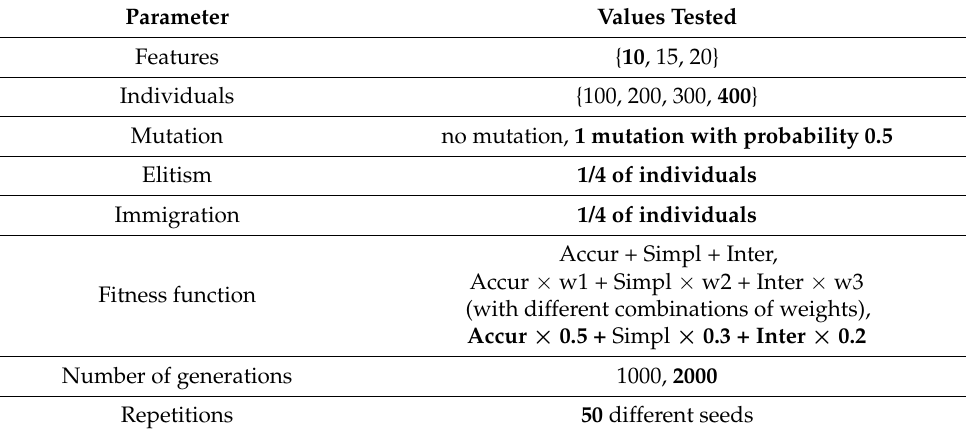
Table 5. All parameters tested for the Genetic Algorithm. The final parameters are presented in bold.